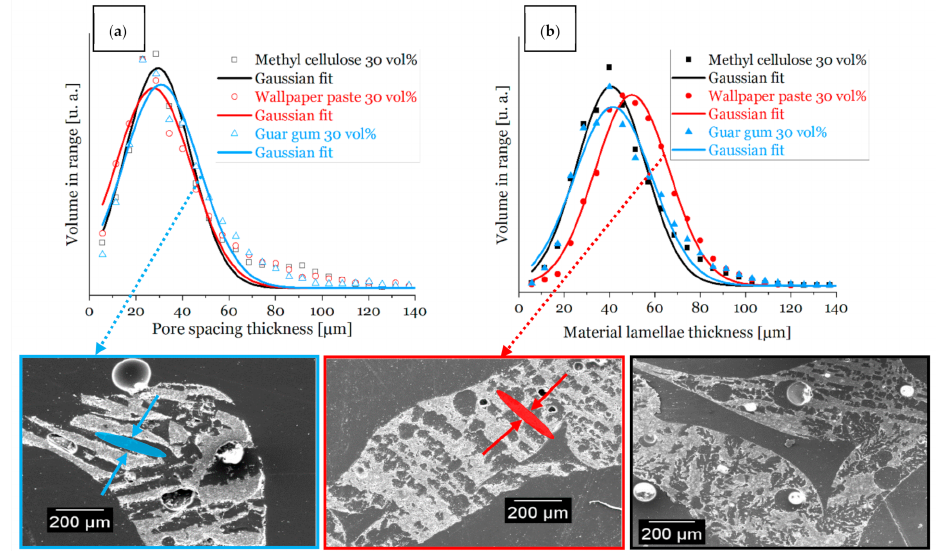
Figure 6. Distributions of the width of material lamella and pore spacings of sintered foam samples from dispersions with 30 vol% solid load measured by µ -CT and SEM images; ( a ): distribution of the pore spacing ( a ) and material lamella thickness ( b ) of sample struts, respectively; (bottom): SEM micrographs of cross-sections of sintered foams; pore spacings and material lamellae exemplary marked with arrows; MC = methylcellulose, WP = wallpaper paste, G = guar